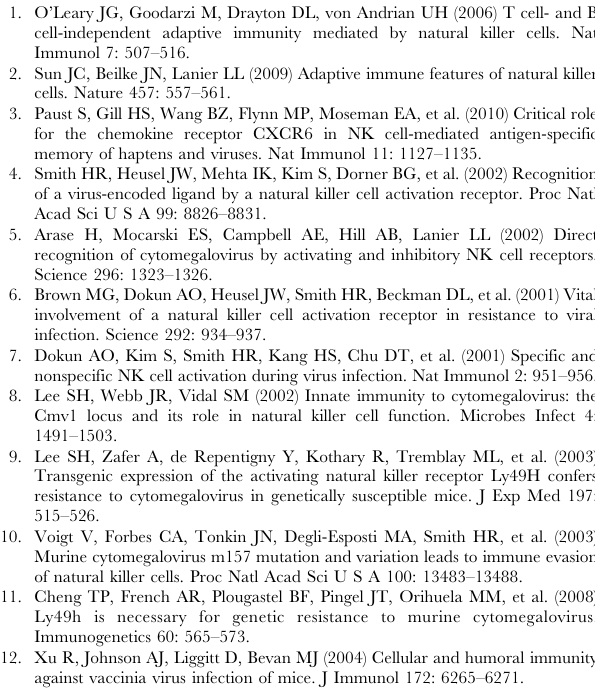
Figure S1 Representative IgH ko priming data. Adult IgH ko mice received 1 6 10 7 pfu rVV-luc intraperitoneally and